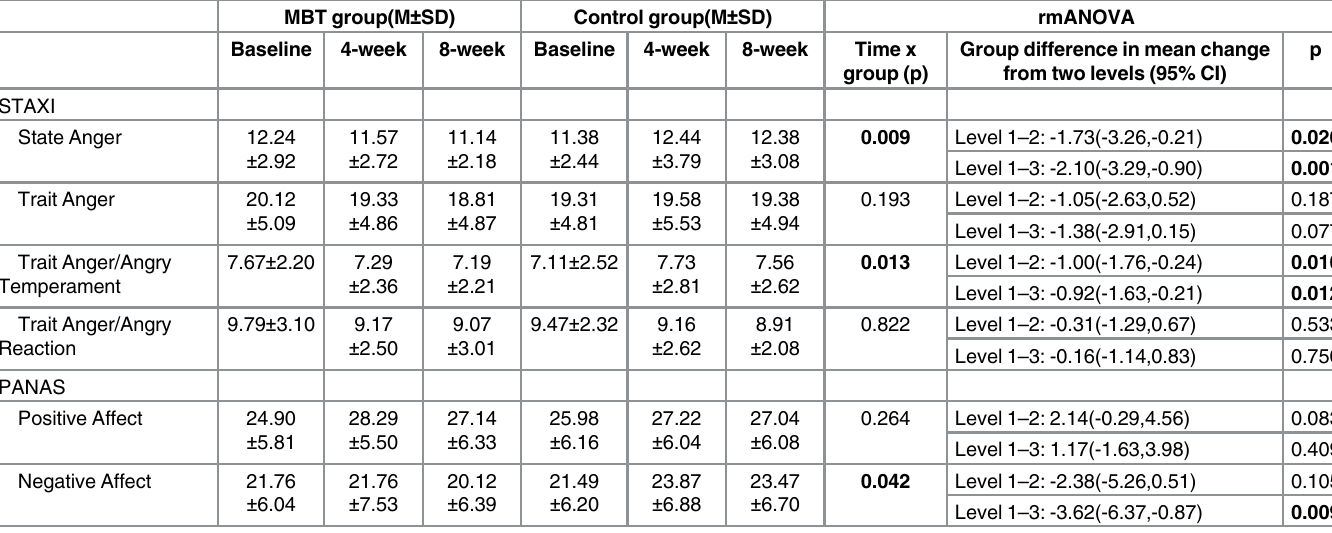
Table 3. Mean STAXI and PANAS scores for the MBT and control groups at each time